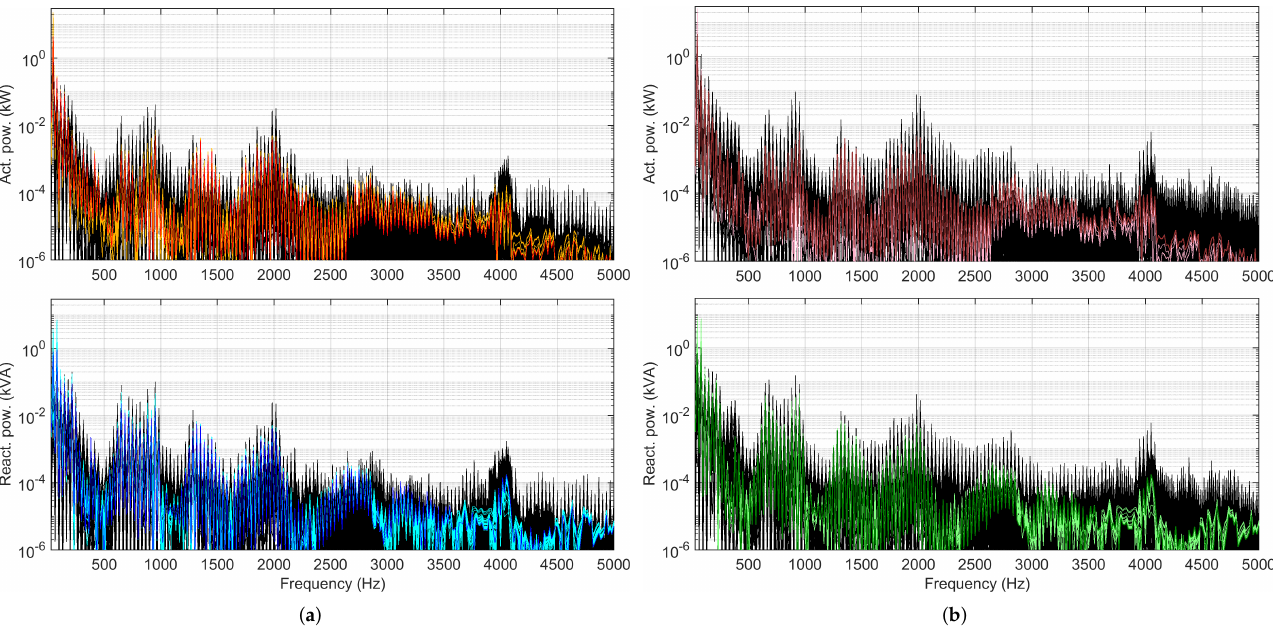
Figure 10. Spectral approximation of the first three PCA components for P h and Q h : ( a ) tractioning, ( b ) braking; the darker colored trace is the mean of the PCA approximation (in lighter